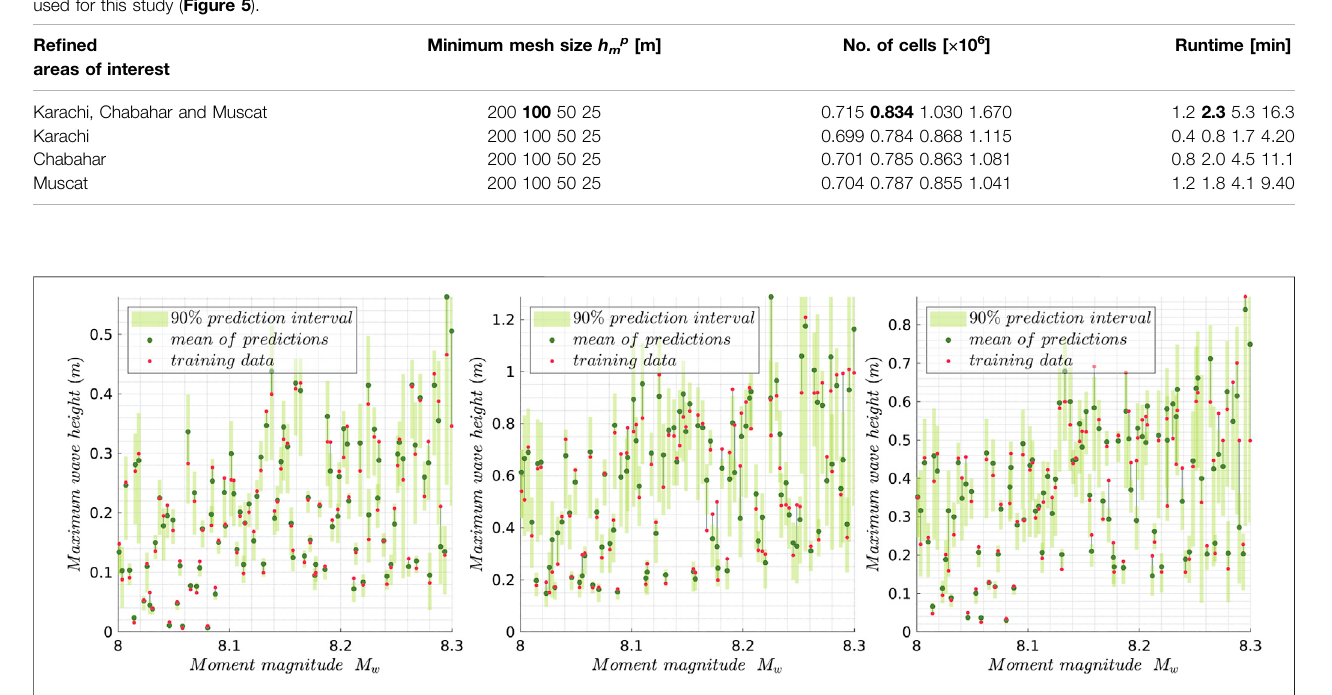
Frontiers in Earth Science |